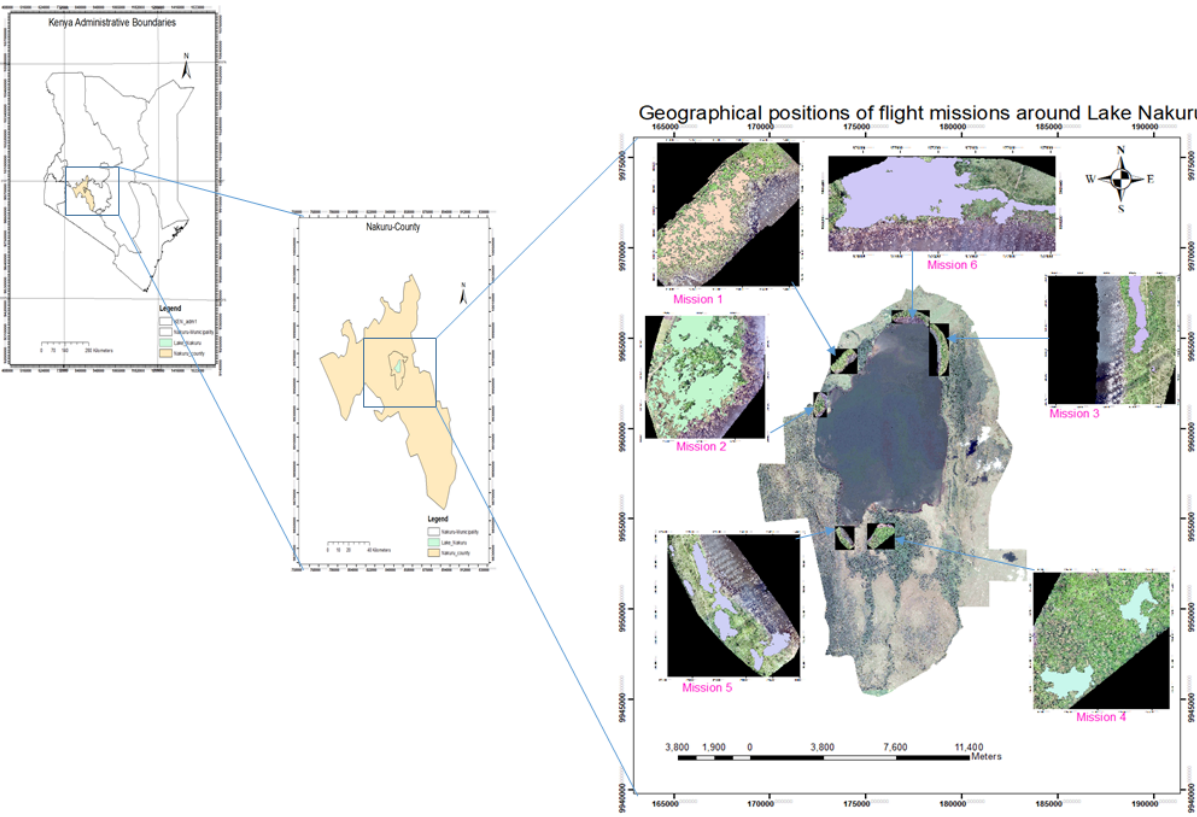
Figure 1. The geographic position of UAV flight missions around Lake Nakuru, projected at WGS84, UTM Zone 37S. species, pointing out the challenge in model transferabilty onto similar